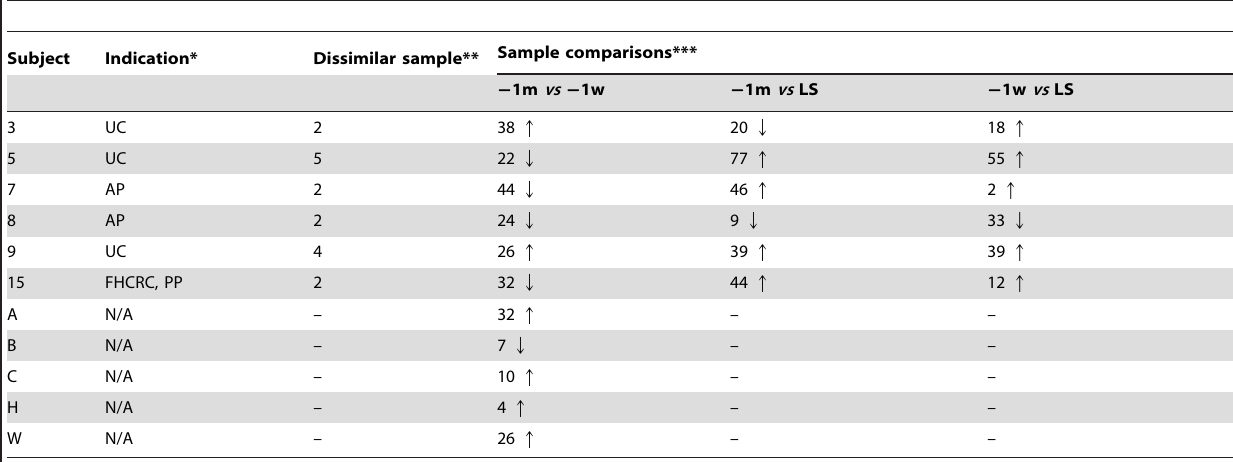
*Abbreviations for indications for colonoscopy: UC, ulcerative colitis, AP, abdominal pain, FHCRC, family history of colorectal cancer, PP, previous polyps, N/A, did not undergo colonoscopy; indication not applicable.